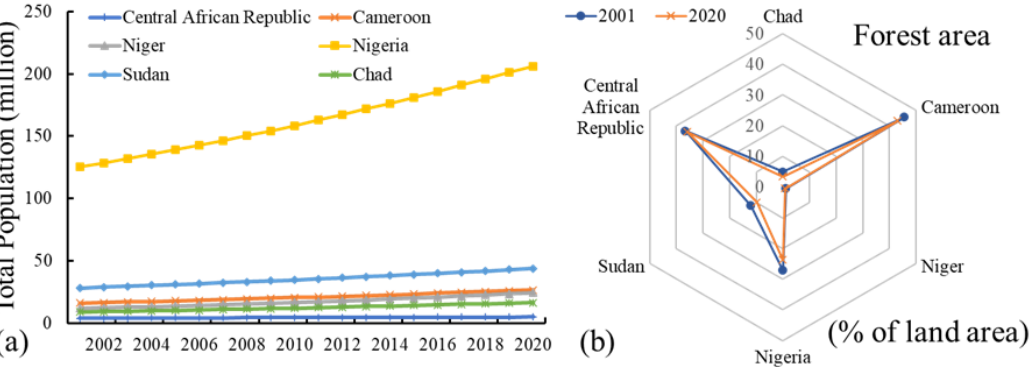
Figure 7. Typical characteristics of Nigeria. ( a ) Total population trends from 2001 to 2020; ( b ) Forest area variation trends from 2001 to 2020.